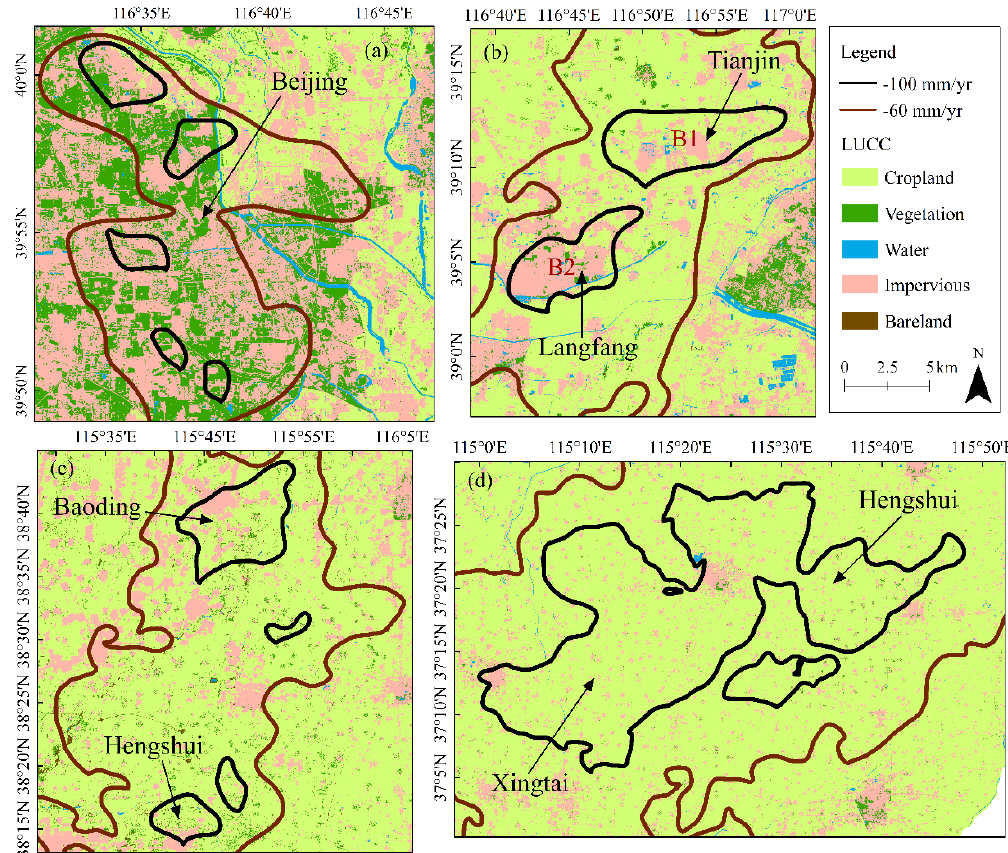
Figure 11. Magnified views of the land use classification in the four highlighted areas: the highlighted areas are marked with black rectangles in the left panel of Figure 10a. ( a ) ,( b ), ( c ) and ( d ) show the land use type with vertical displacement rate exceeds 60 mm / yr in Zone A, B,C and D, respectively. Table 3. Land use conditions in zones A to D with subsidence rates greater than 100 mm / yr. Major Land Use (%) Zone List Area (km 2 ) Cropland Impervious